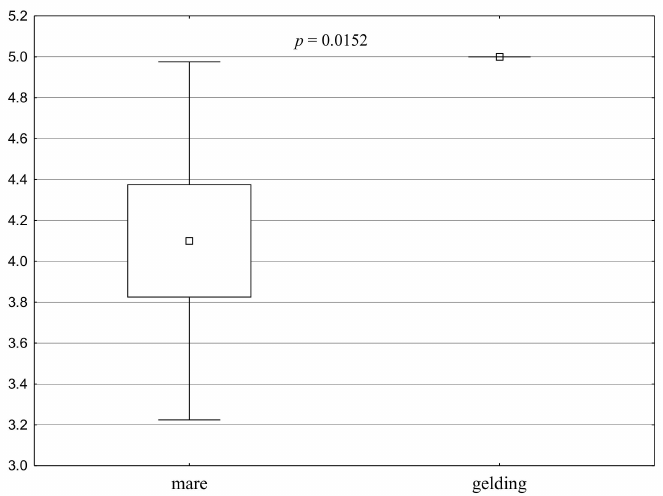
Figure 2. Distribution of Test 4 results for the groups—Unknown surface test, stage 4.1: points for the distance from the new surface at which the horse first stopped (a square shows the mean, a box corresponds to the range of the mean ± standard error, and “whiskers” show the range of the mean ± standard deviation). A significant difference between the groups is confirmed by the value of p < 0.05.